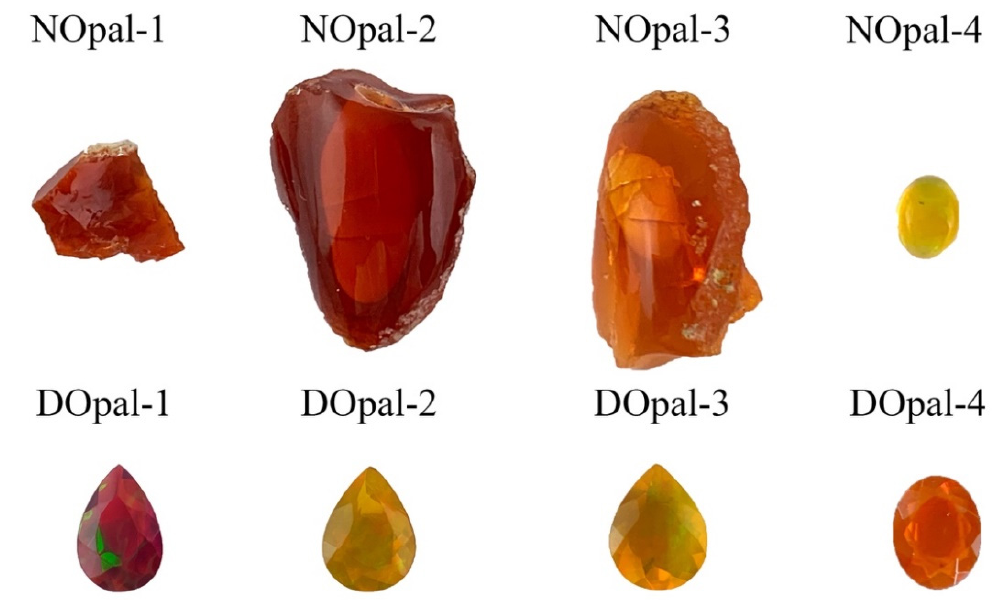
Figure 1. Shown here are four natural samples, ranging from 0.49 to 18.01 ct, and four dyed samples weighing 0.56–1.26 ct.